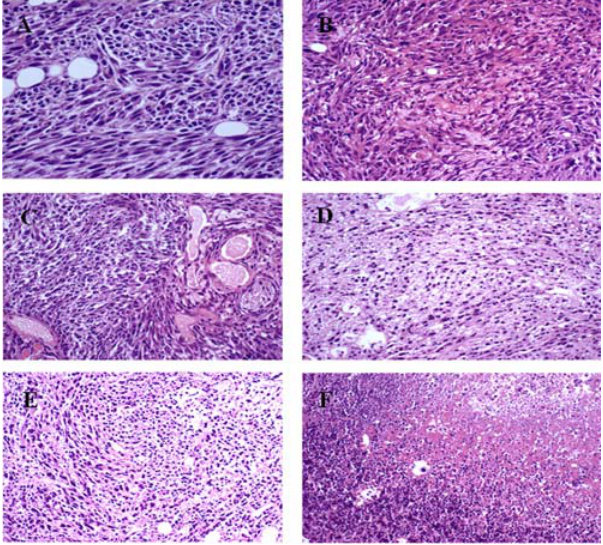
Figure 4. TUNEL analysis at different times after the pulses delivery. A: control; B, C and D: respectively 5 min and 1 and 24 h after